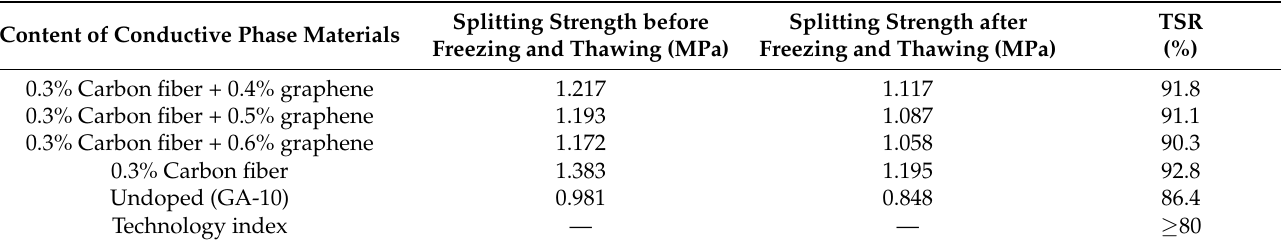
Table 15. Test results of freezing–thawing splitting of asphalt mixture.